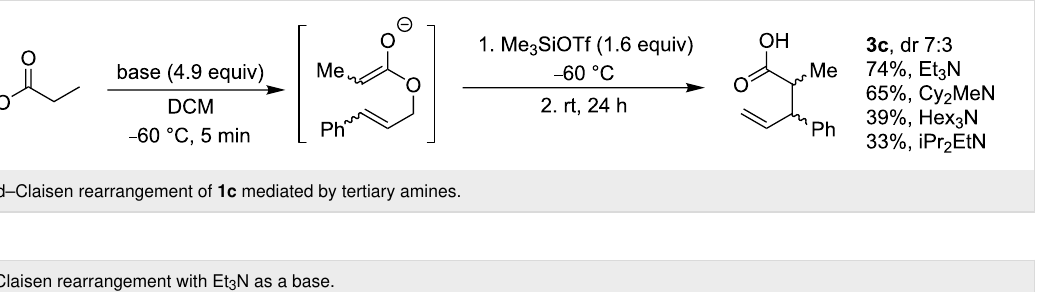
Table 2: Ireland–Claisen rearrangement with Et 3 N as a base.